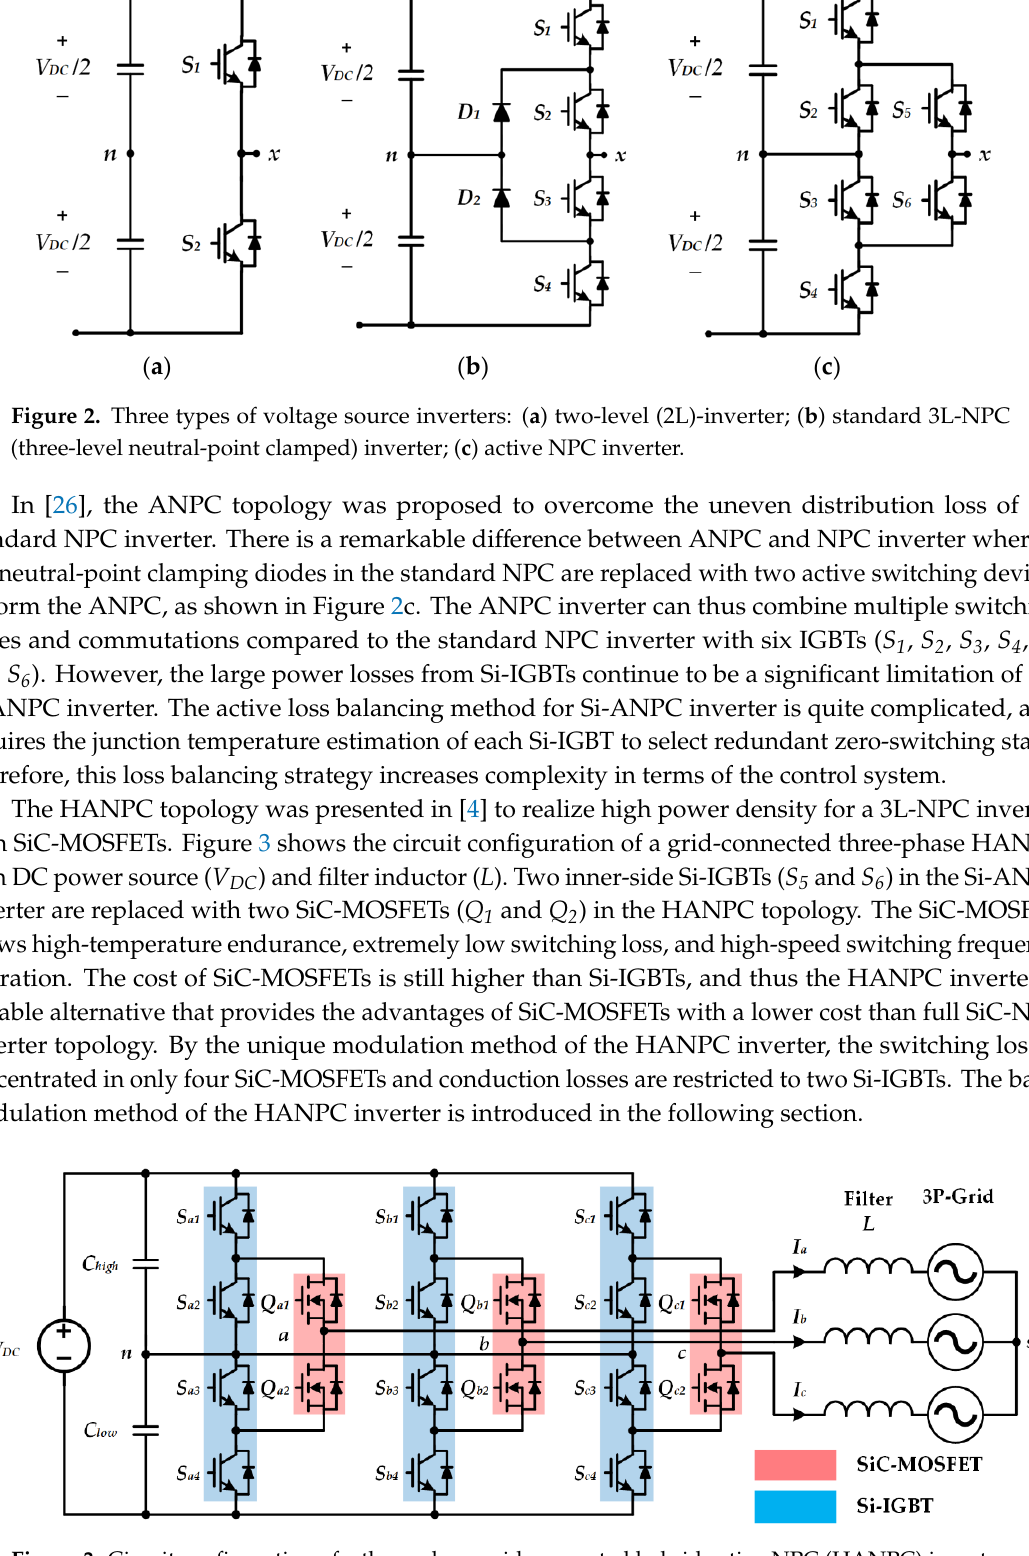
Figure 3. Circuit configuration of a three-phase grid-connected hybrid active NPC (HANPC) inverter.